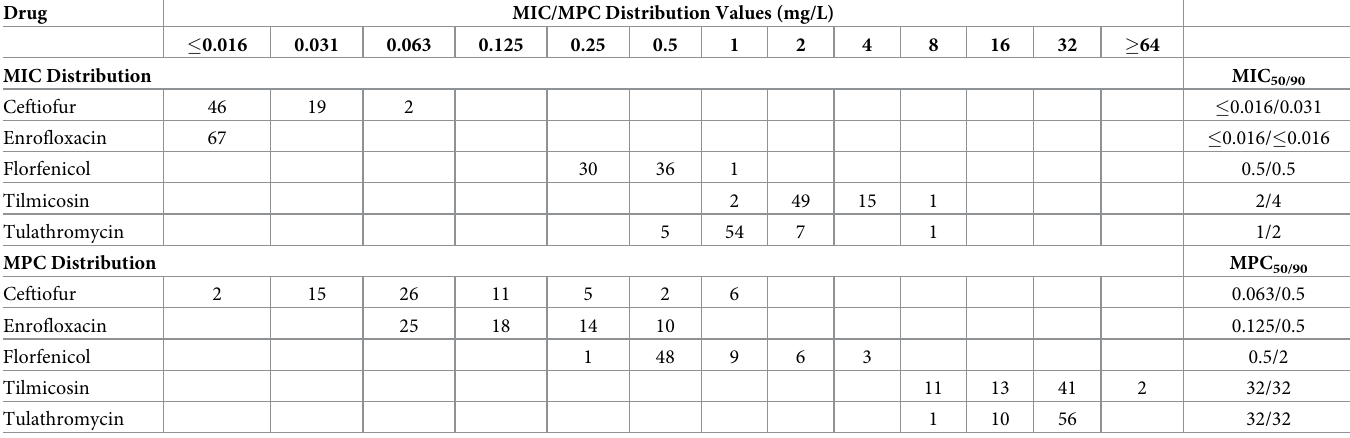
Table 1. MIC and MPC values for 67 A . pleuropneumoniae isolates from swine.